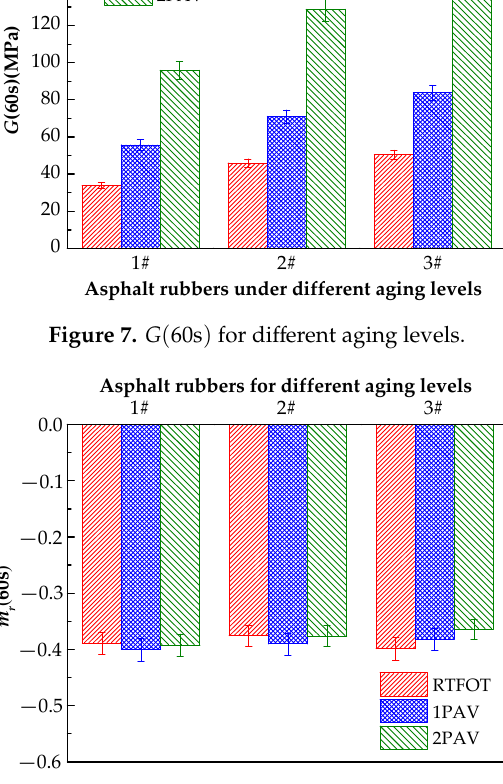
Figure 8. m r ( 60s ) for di ff erent aging levels.